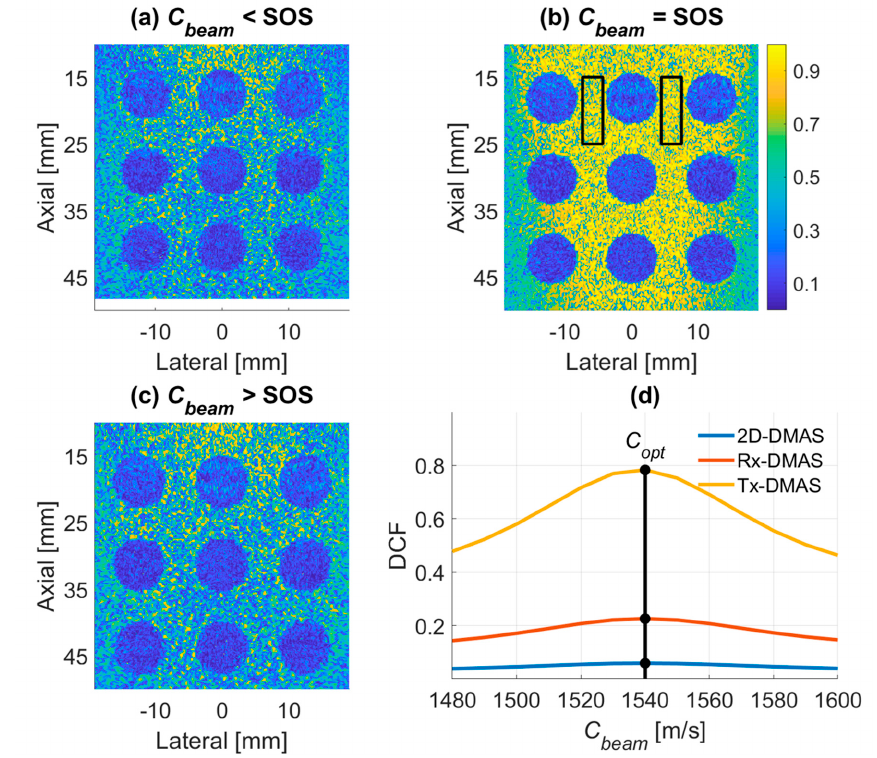
Figure 1. ( a – c ) Typical DCF maps of the simulation phantom for C beam greater than, equal to and less than the actual SOS, respectively. ( d ) Plot of average DCF value as a function of C beam in different DMAS beamforming methods.